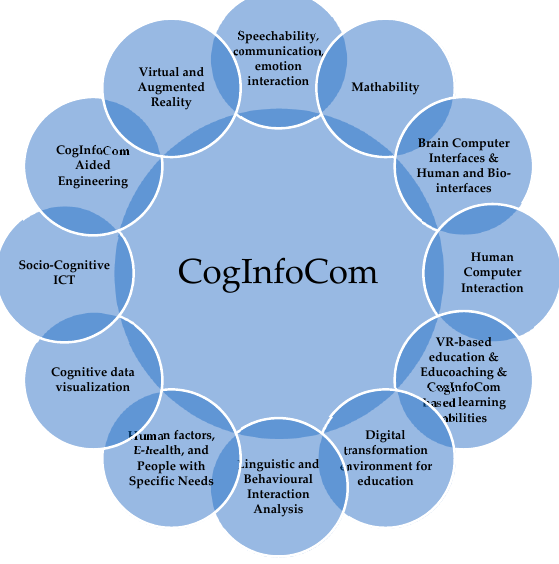
Figure 1. The main related topics of cognitive infocommunication (CogInfoCom).